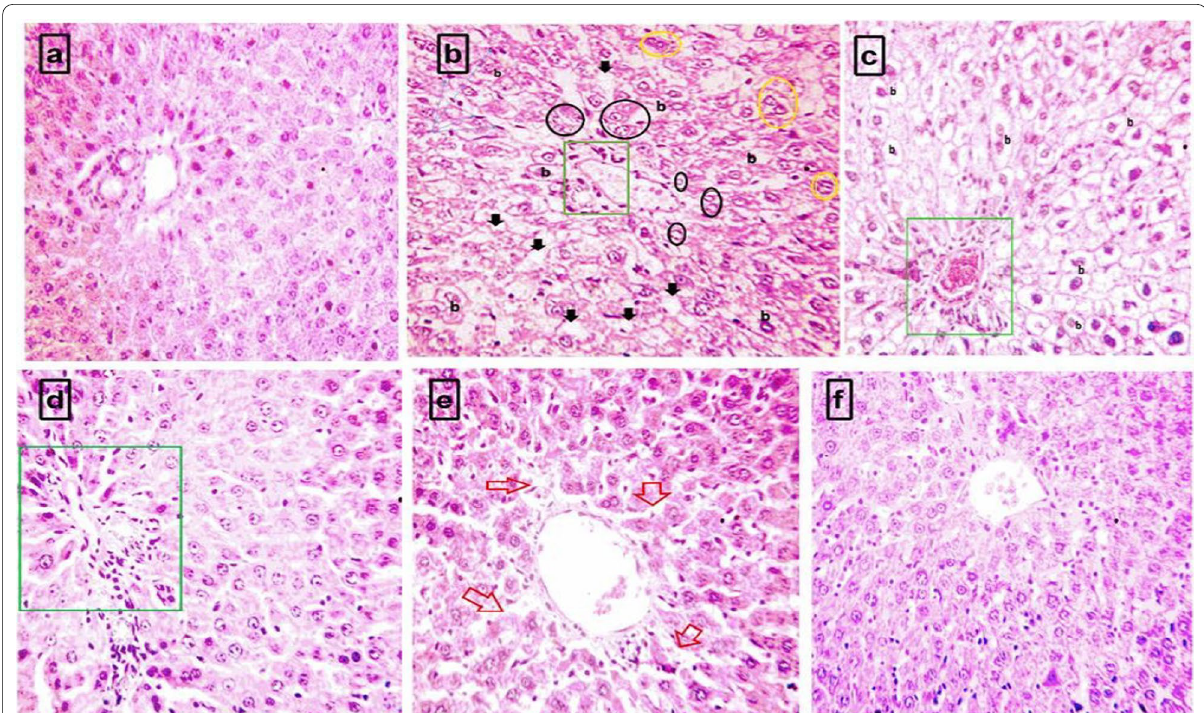
Fig. 3 Histopathology of the liver from control rat ( a ) showed normal architecture of hepatocytes. HFHF diet rats ( b , c ) caused liver steatosis (black arrows), hepatocytes ballooning ( b ), green square boxes indicate immune cell infiltration, yellow circles indicate binuclear hepatocytes, black circles show that glycogenated nuclei are mainly located in the area surrounding the portal tract, and Kupffer cells (blue arrows). Silymarin-treated HFHF-challenged rat ( d ) showed normal hepatocytes but immune cell infiltration (green square) is seen, curcumin-treated HFHF-challenged rat showed hepatic sinusoidal dilatation (red arrows), ( e ) and celery-treated HFHF-challenged rat ( f ) normal architecture almost similar to